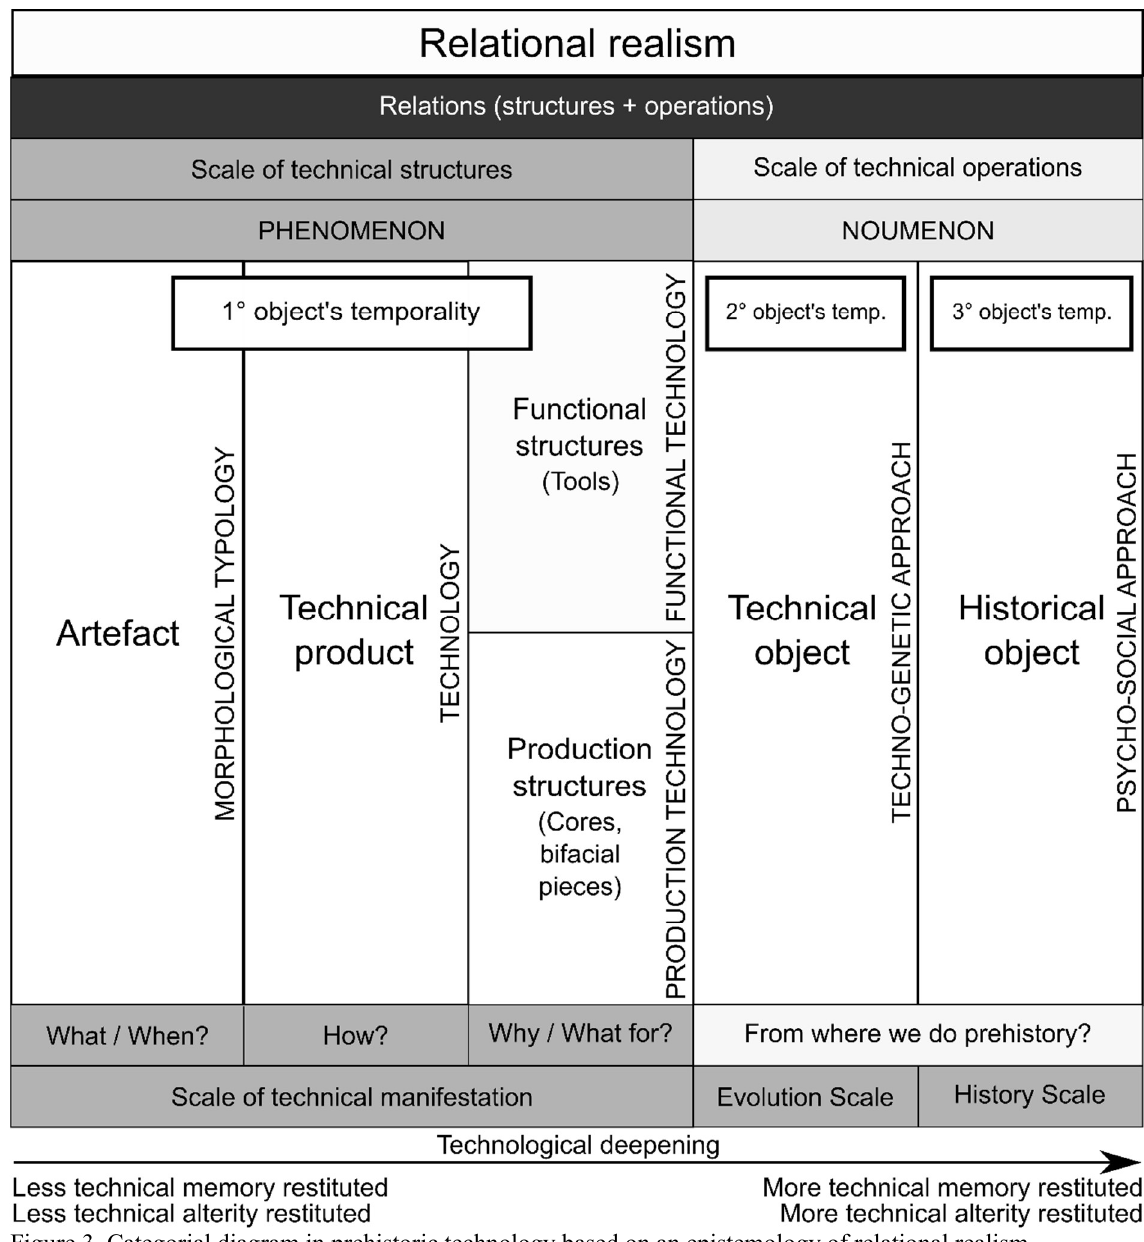
Figure 3. Categorial diagram in prehistoric technology based on an epistemology of relational